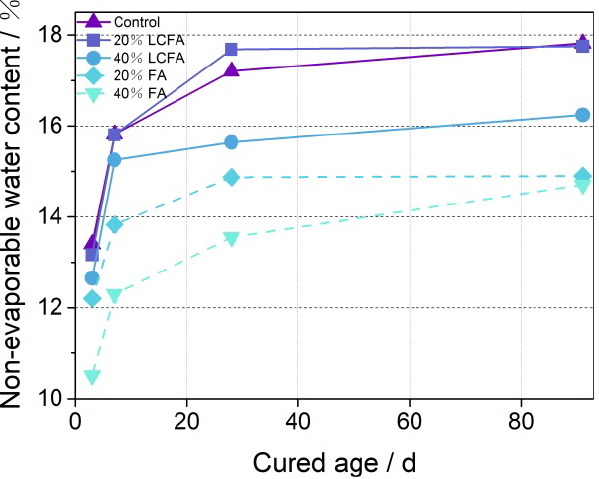
Figure 11. Non-evaporated water content of OPC-LCFA and OPC-FA samples.